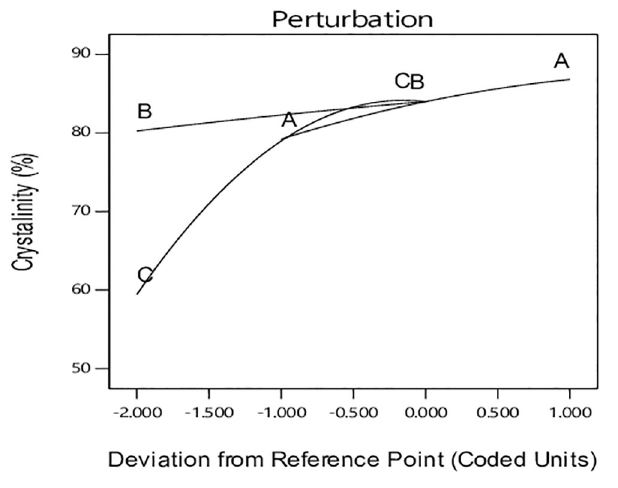
Fig 11. Perturbation chart for crystallinity